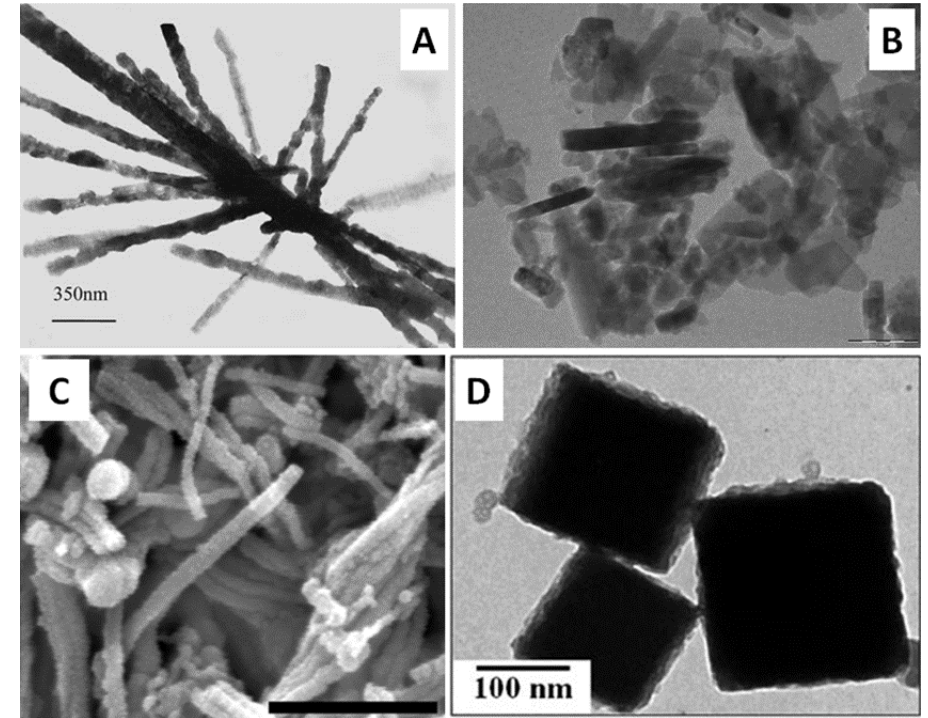
Figure 5. ( A ) CaCO 3 nanorods synthesized by HEN-Qn1, a mixture of thermophilic bacteria strains. Adapted from Reference [86] with permission from Springer. ( B ) ZnO nanorods obtained by mixing biomass of seaweed Padina tetrastomatica and ZnCl 2 . Scale bar: 100 nm. Adapted from Reference [87] with permission from Wiley. ( C ) Hematite (Fe 2 O 3 ) nanowires synthesized by biofilms of